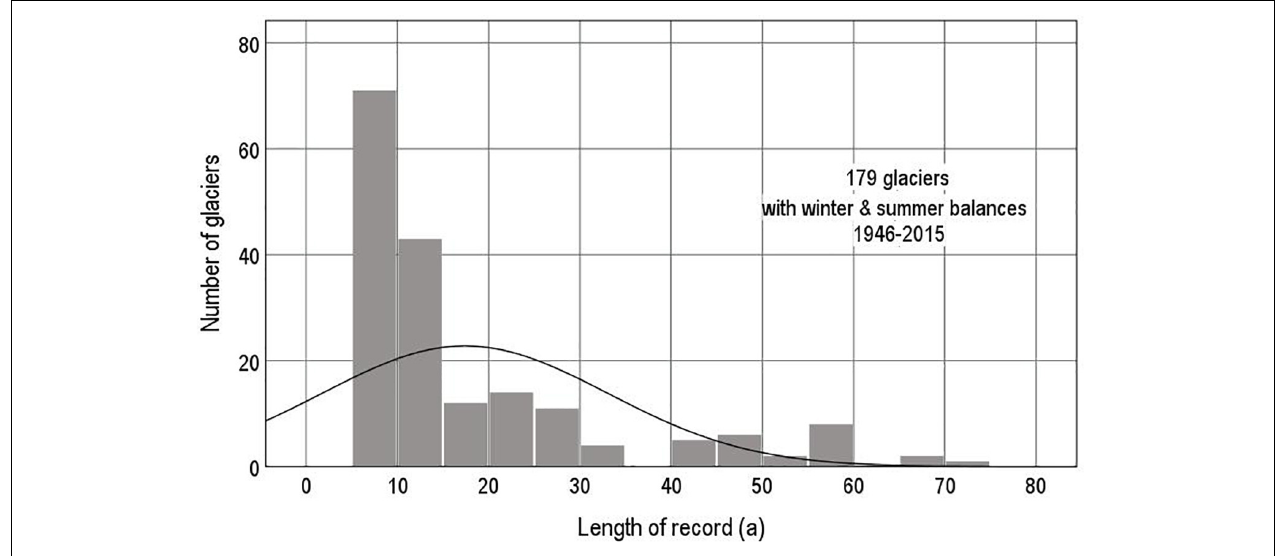
FIGURE 2 | Number of glaciers with measured annual, winter, and summer balances for different lengths of series in the years 1946–2015.